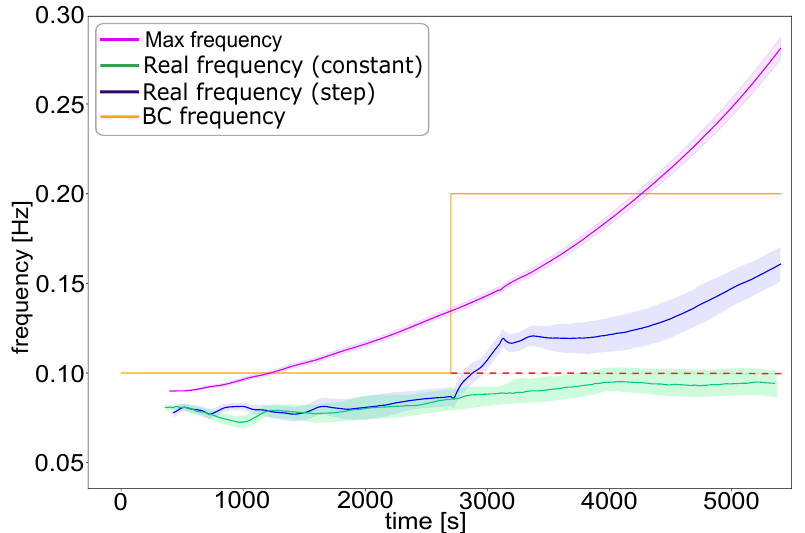
Figure 20. Comparison of service provision frequencies over time between simulations with constant f BC and those with increased f BC